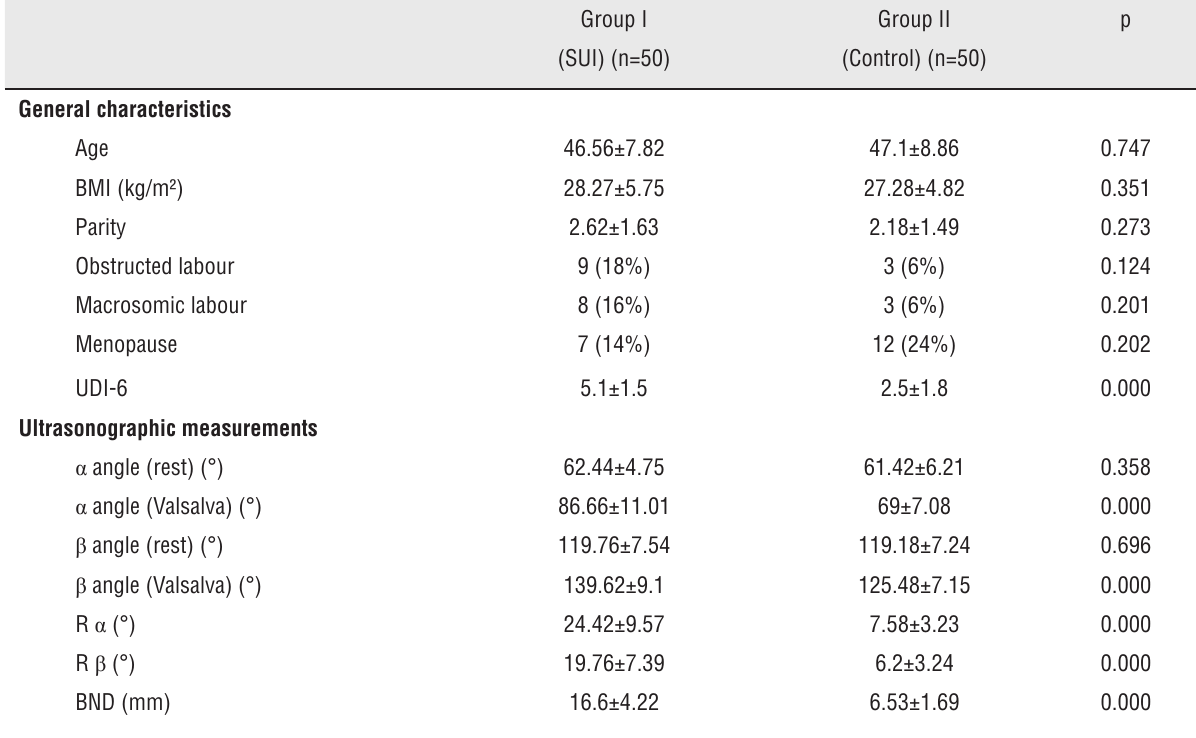
Table 1 - Comparision of general and ultrasonographic characteristics of